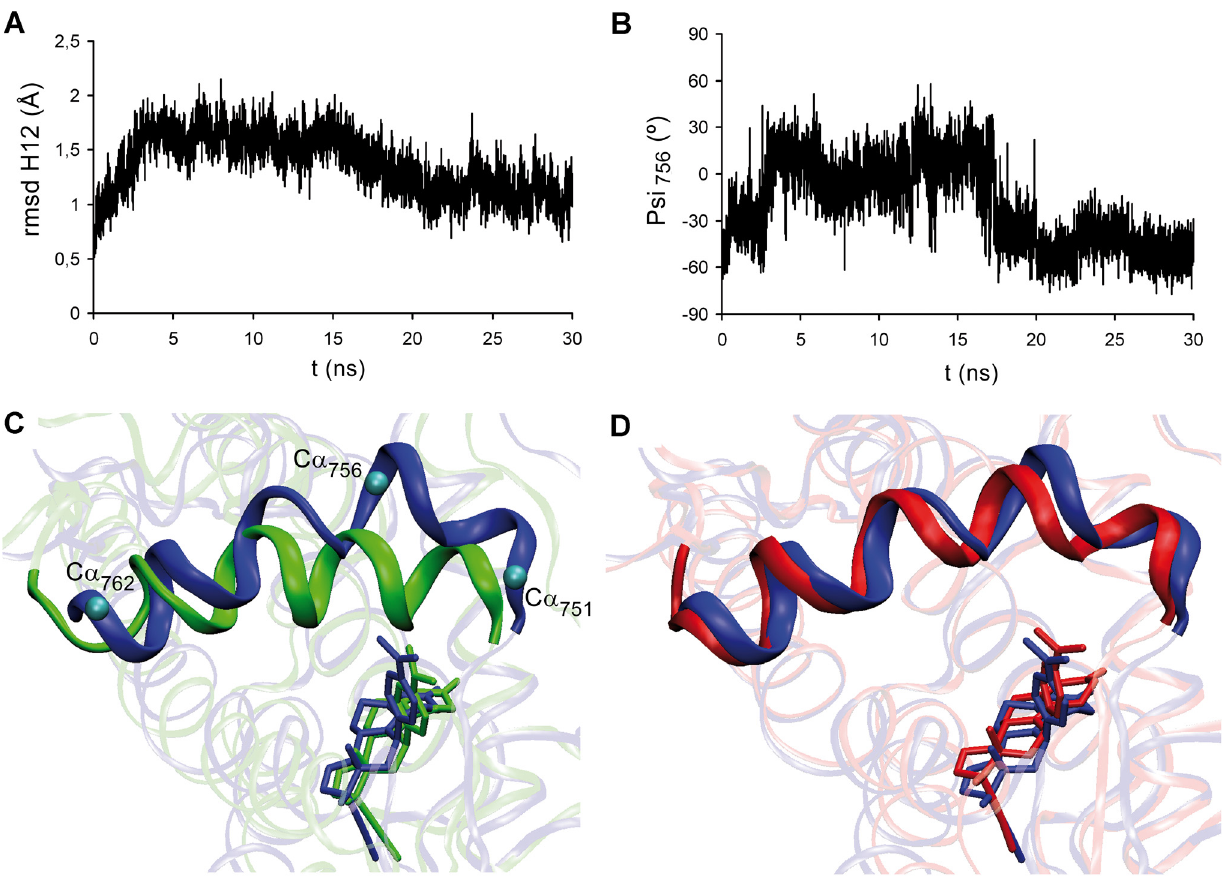
Figure 7. MD simulation of GR LBD-RU486 complex. A . Root mean squared deviation (rmsd) from the initial structure measured over the H12 (751–766) backbone atoms of the GR LBD-RU486 complex. B . Time evolution of psi 756 angle. C . Superposition of the initial structure (green) of GR LBD-RU486 complex with the structure at 15 ns (blue). D . Superposition of the structures at 15 ns (blue) and at 30 ns (red).